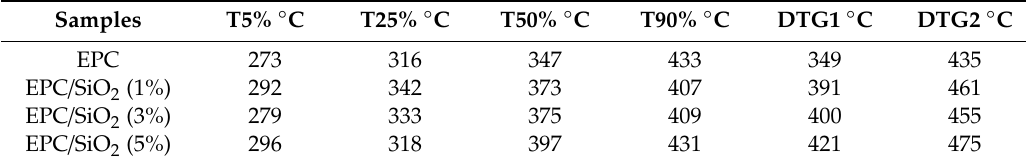
Table 2. The thermal properties of EPC and EPC / SiO 2 nanocomposites.